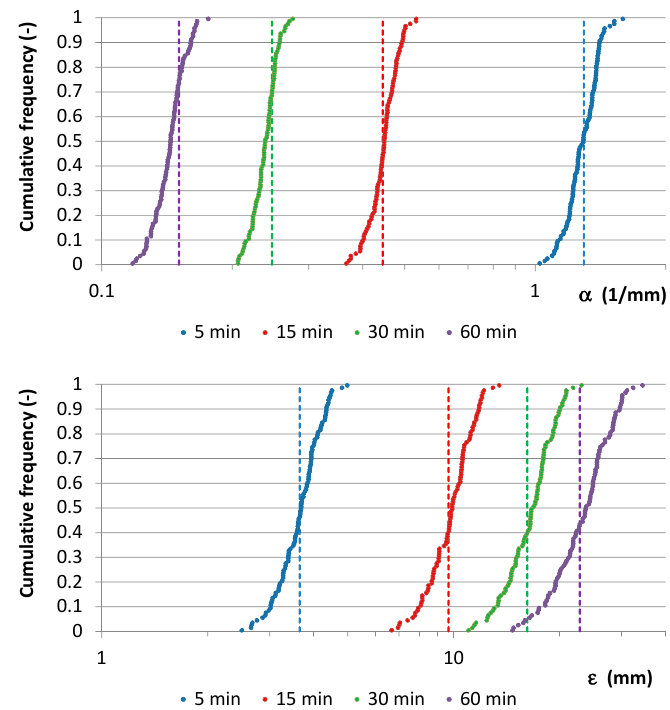
α ε ( top ) and ( bottom ). The